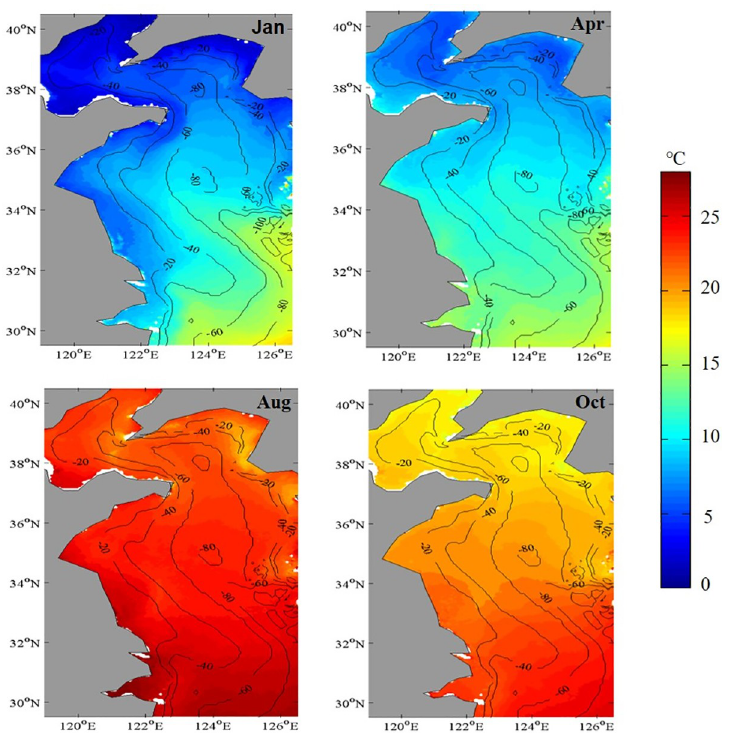
Fig 5. Monthly mean distributions of SST in the Yellow Sea, China during 2003–2015.